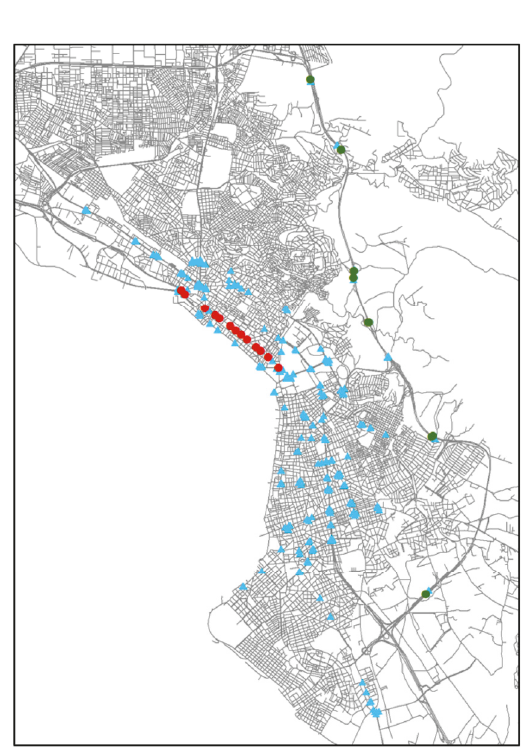
Figure 1: Mobility sensors in the city of